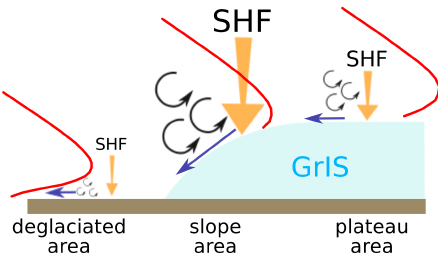
Figure 10. Schematic overview of the sensitive winter processes driving Greenland’s surface temperatures as a function of the posi- tion and slope on the GrIS. Blue arrows indicate the surface wind velocities, orange arrows the downward SHF, the curly vectors the amount of turbulence, and the red lines the vertical temperature profile. Deglaciated areas are characterized by very weak surface winds and turbulence prohibiting an efficient SHF and resulting in very strong temperature inversion. Slope areas encounter strong sur- face winds due to the katabatic forcing, inducing strong turbulence and an efficient SHF eventually resulting in relatively warm surface temperatures and a weak inversion layer. The plateau area depicts a somewhat intermediate state with moderate strength in all shown